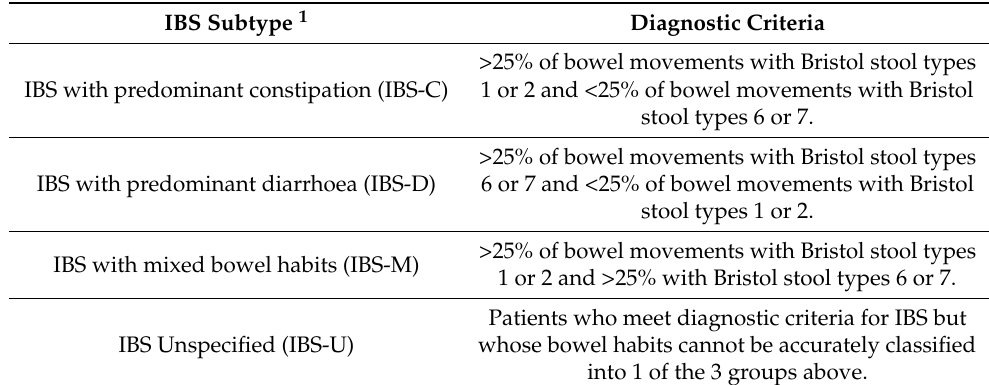
Table 1. Rome IV diagnostic criteria for IBS subtypes